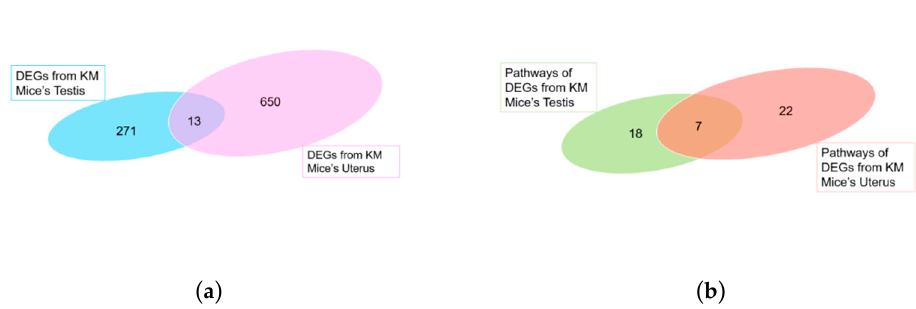
Figure 4. Comparison of transcriptional profiles of testis and uterus during Toxoplasma gondii infection. ( a ) Venn diagrams of differently expressed genes (DEGs) between testis and uterus. Genes with base mean |log 2 (fold change)| ≥ 1, and p < 0.05 were collected for analysis. ( b ) Venn diagrams of pathways of DEGs between KM mouse testis and uterus were collected by using the Kyoto Encyclopedia of Genes and Genomes (KEGG) database.